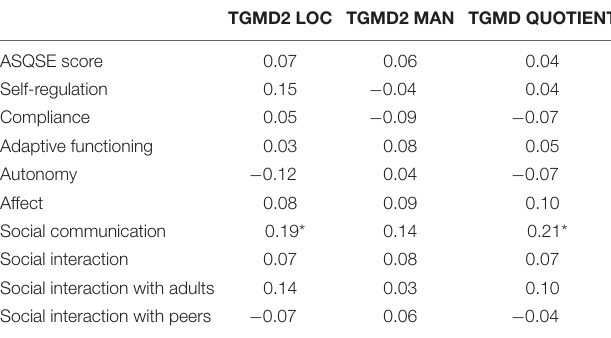
TABLE 2 | Spearman’s correlation coefficients of TGMD2 scores and ASQSE score and ASQSE